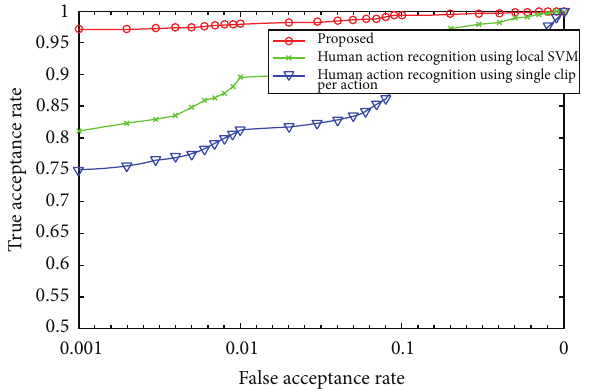
Figure 11: An ROC analysis for the proposed and other competitive techniques using only the medial frames of